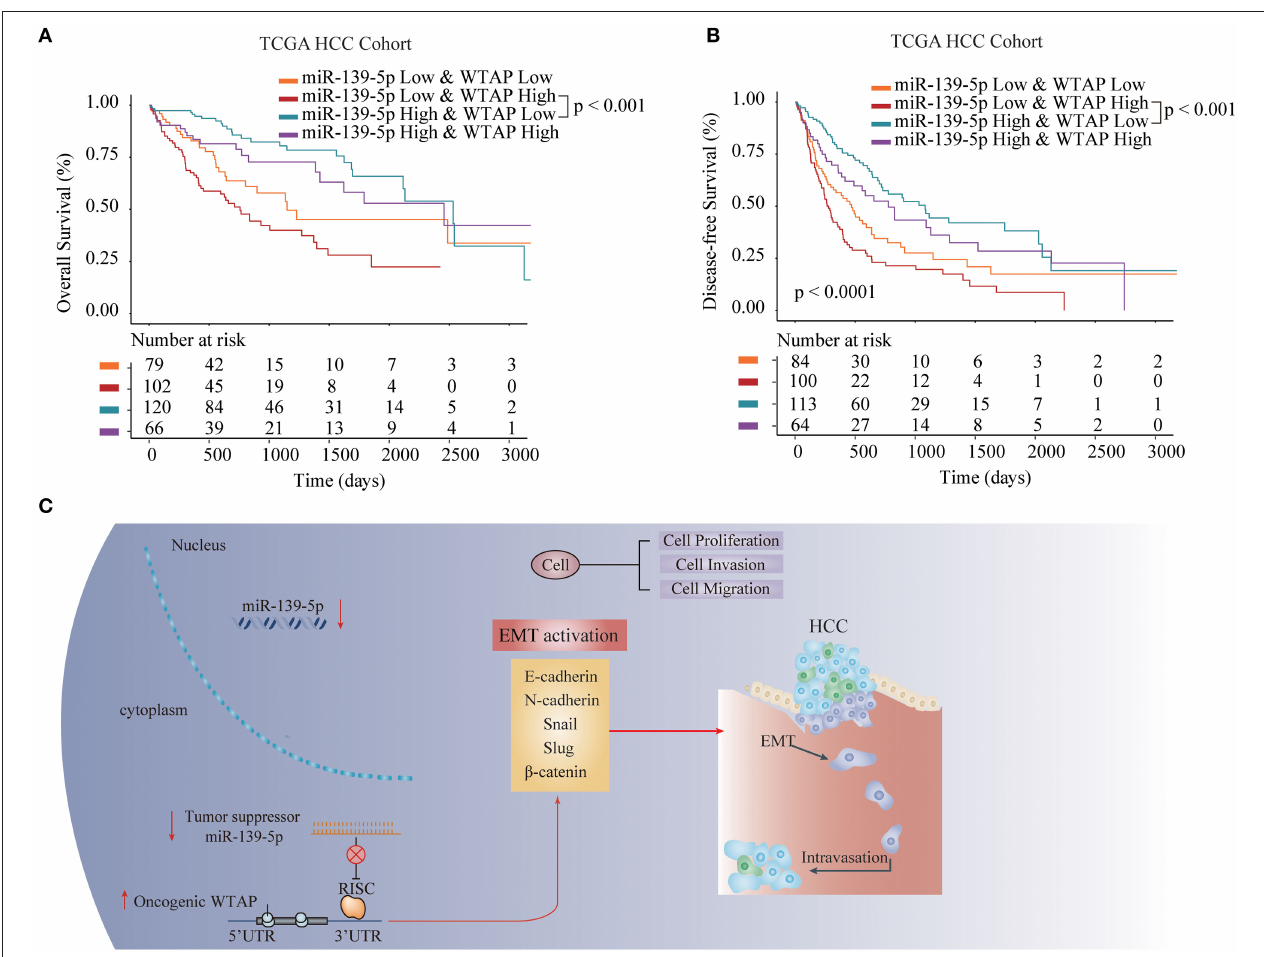
FIGURE 8 | WTAP/miR-139-5p expression is associated with the prognosis in patients with HCC. The Kaplan–Meier analysis of the OS (A) and disease-free survival (DFS) (B) in patients with HCC having the different expression levels of miR-139-5p and WTAP. (C) The proposed working model of the miR-139-5p/WTAP axis in HCC. miR-139-5p functions as a tumor suppressor through inhibiting the WTAP expression in HCC. miR-139-5p/WTAP axis plays a substantial role in inhibiting the tumorigenesis and reversing the metastasis of HCC through the EMT